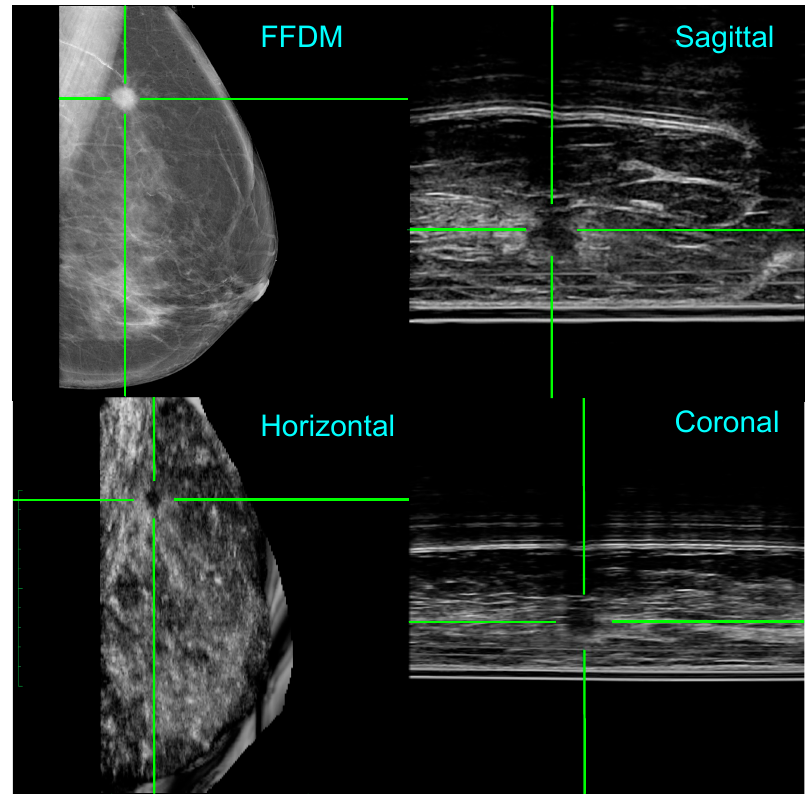
Figure 5. Co-registration of the FFDM in the horizontal plane and the ABUS images in the horizontal, coronal, and sagittal planes for Patient 2. A malignant lesion has been highlighted by cross hairs in the ABUS views and is clearly co-registered in the FFDM image. Note that, for the ABUS images, the sagittal plane view is the acquired image, whereas the coronal and horizontal plane views have been reconstructed.